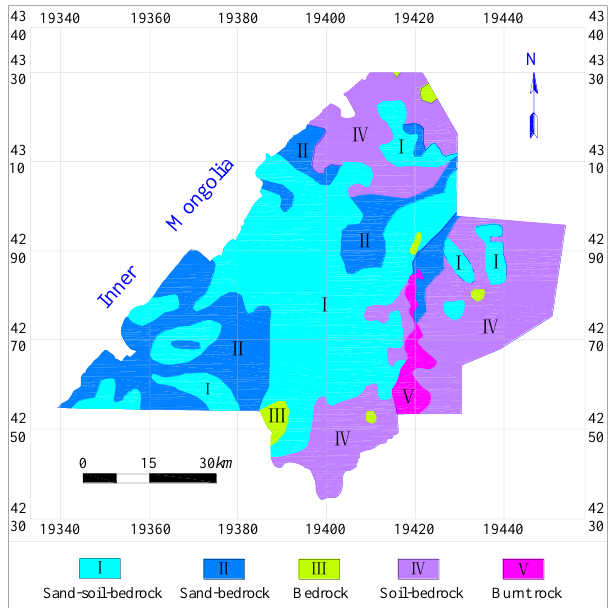
Figure 4. Stratigraphic structure map (Xi'an geodetic coordinate system 1980; in km).